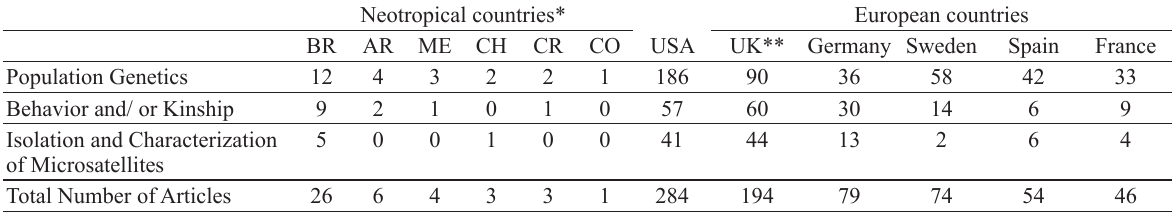
Isolation and Characterization of Microsatellites